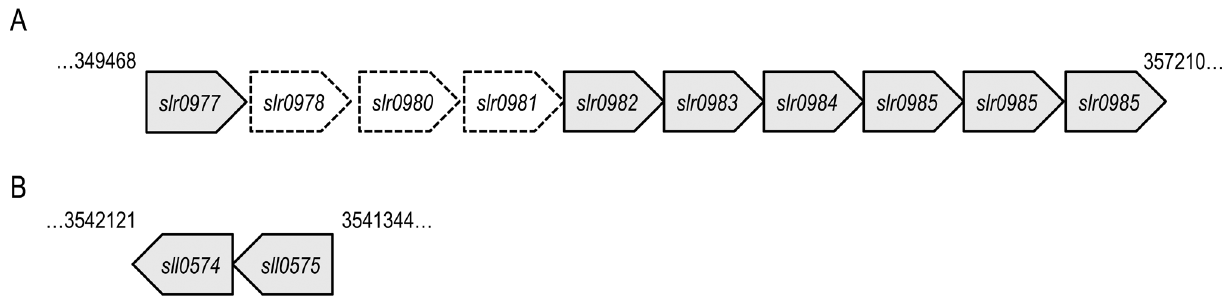
Figure 1. Genetic organization of the slr0977 gene cluster. (A) slr0977 and slr0982 are predicted to encode a permease and ATPase components of an ATP-transporter, respectively. slr0978-0981 encode hypothetical proteins of unknown function. slr1610 is a predicted methyltransferase. (B) sll0574 and sll0575 are predicted to encode a permease and ATPase components of an ATP-transporter, respectively.